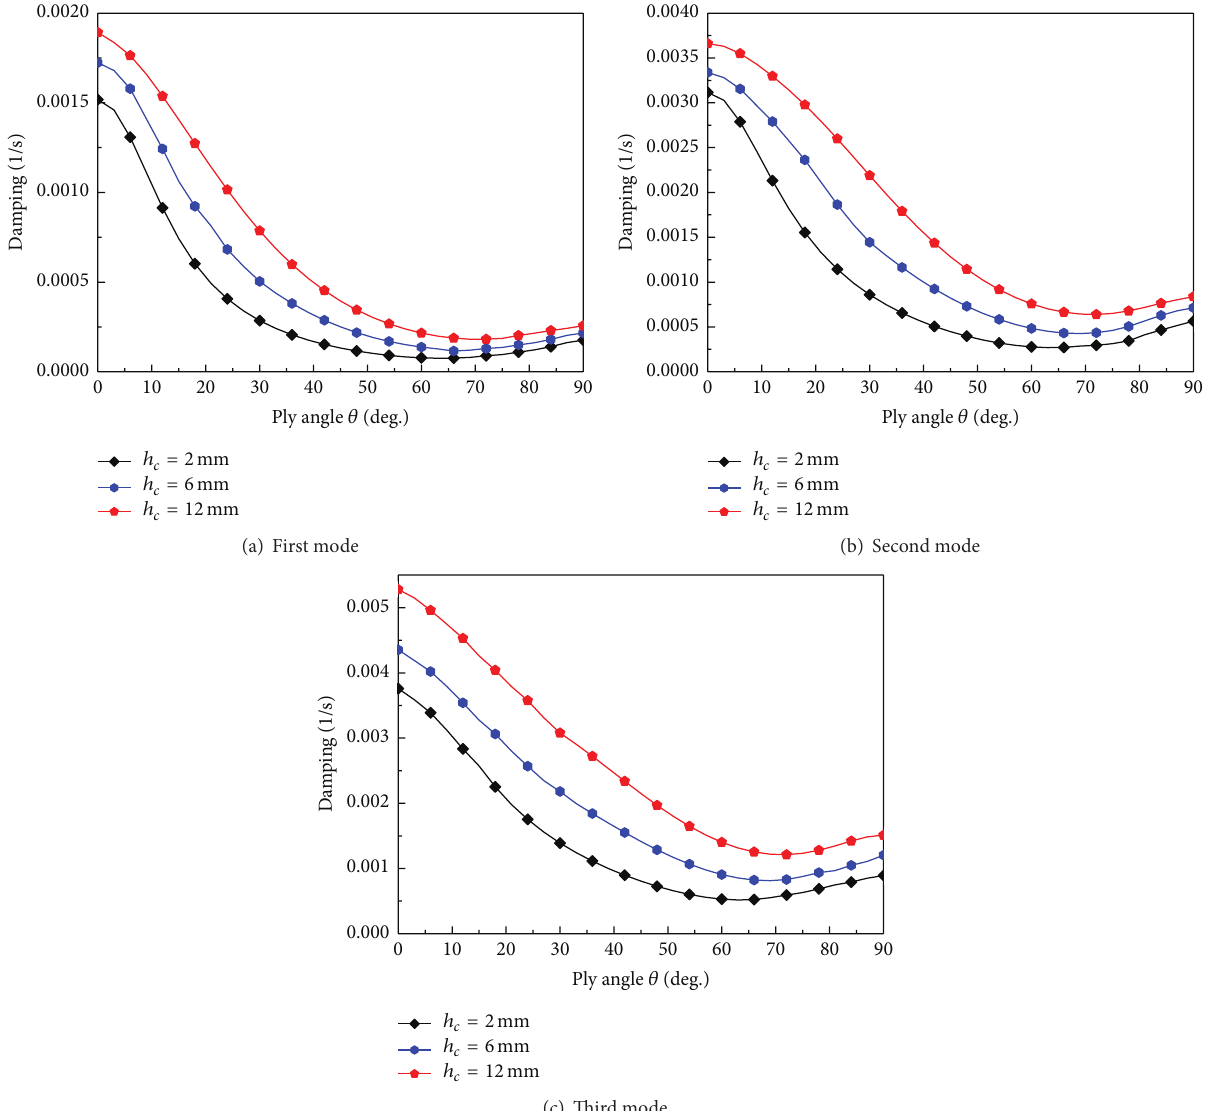
Figure 3: The first three dampings versus fiber angle for various thicknesses of constraining layer ( ℎ V = 2 mm, Ω = 0).